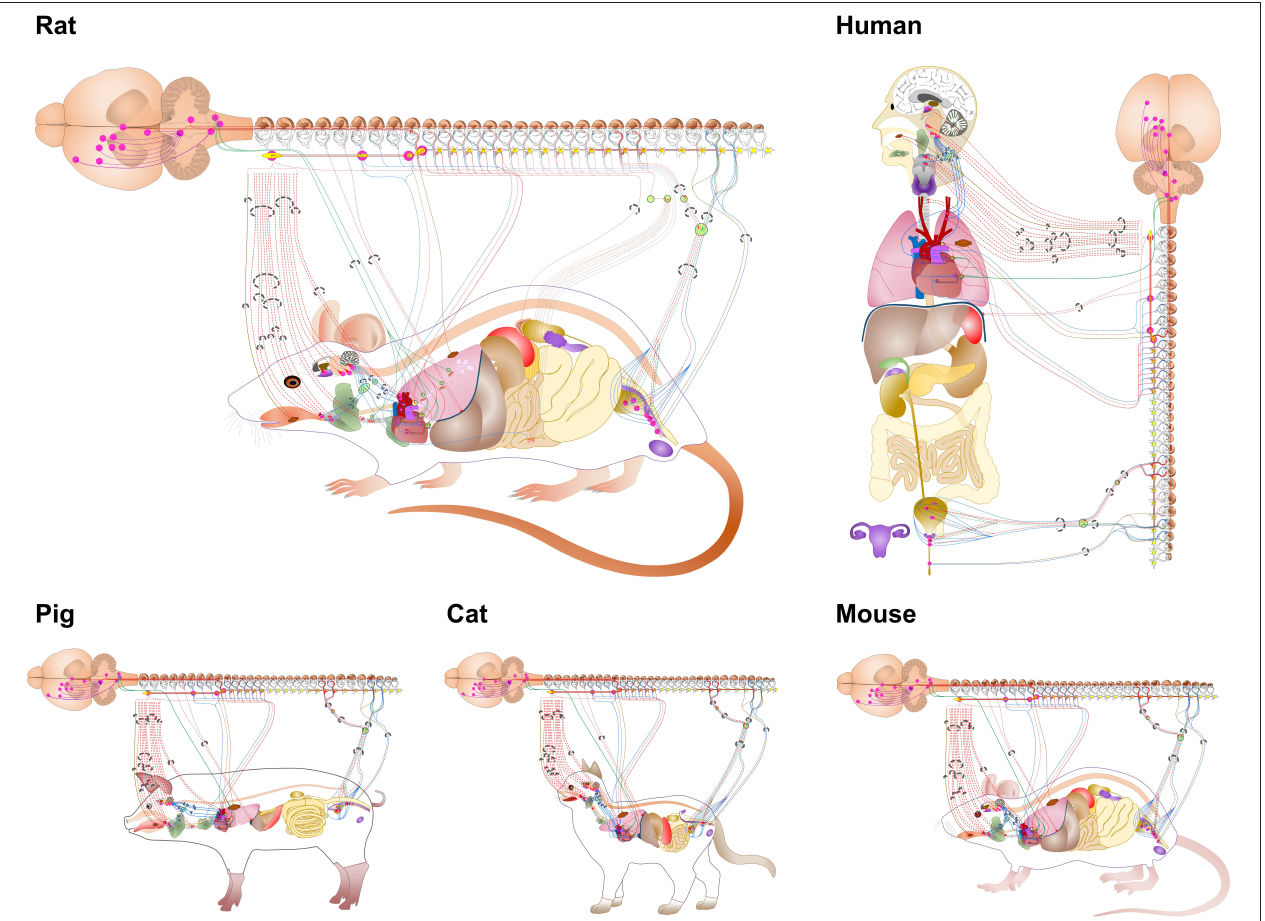
FIGURE 4 | Flatmaps of individual species available through the SPARC portal at sparc.science/maps. Zooming in on these mapping diagrams provides additional levels of detail and clickable links that retrieve relevant SPARC data resources from Discover via the SKG (SPARC Knowledge